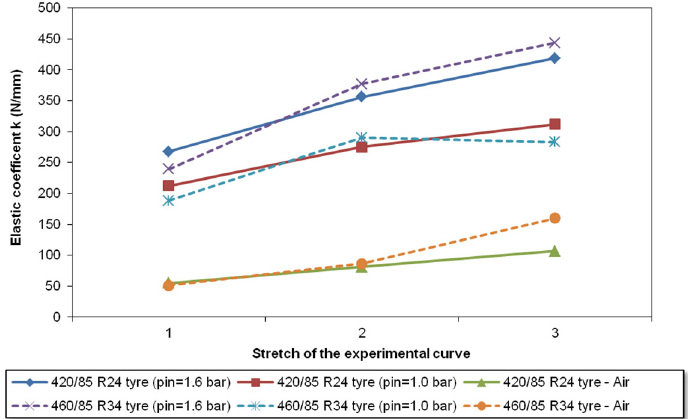
Figure 6. Values of the average elastic coefficients in correspondence with the different stretches of the loading curves of the 420/85 R24 and 460/85 R34 tyres.